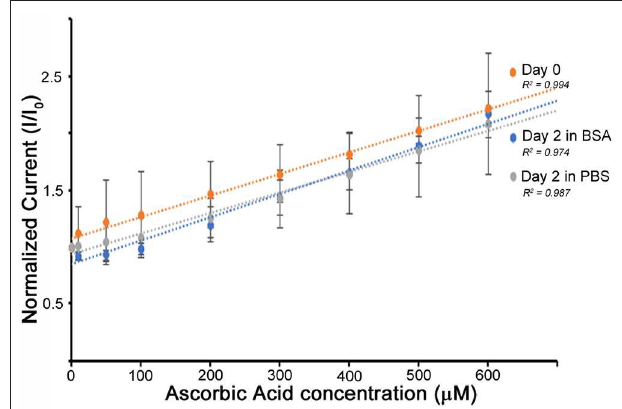
FIGURE 5 | The O3E biosensor was evaluated in the presence of a blocking agent (BSA). The biosensors were immersed in 40 mg/ml BSA solution (in 0.1M PBS, pH 7.4) (blue line), or PBS buffer (as control) (gray line) over 2 days. A linear response is maintained over 2 days, with very small change in comparison to the starting biosensors (Day